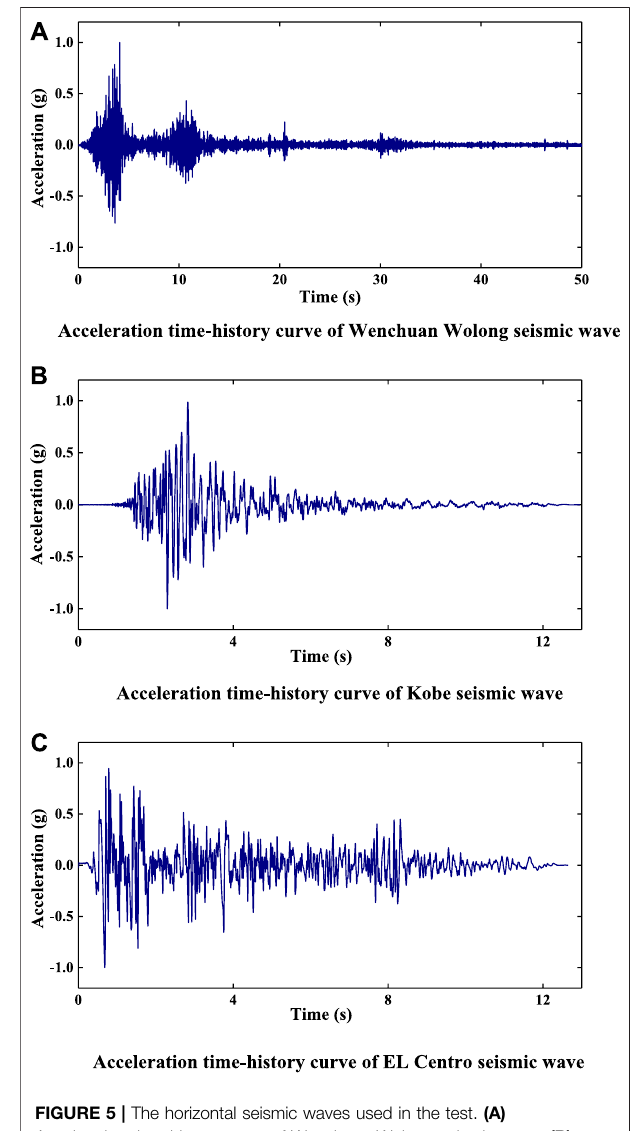
FIGURE 5 | The horizontal seismic waves used in the test. (A) Acceleration time-history curve of Wenchuan Wolong seismic wave. (B) Acceleration time-history curve of Kobe seismic wave. (C) Acceleration time- history curve of EL Centro seismic